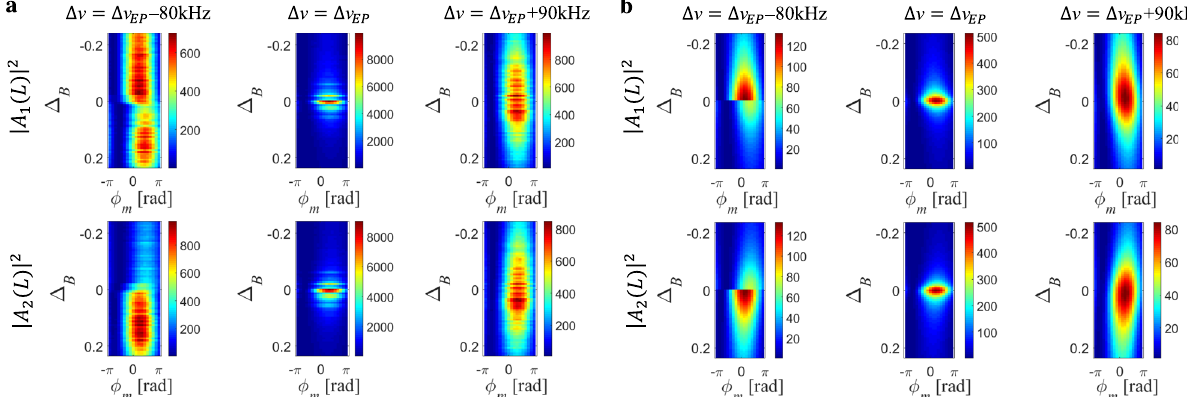
Fig. 5 Enhanced response to small-scale variations from the BFS in eigenmode projections around the EP. a Measured and b calculated squared moduli Þ . The top of the output probe wave projections as a function of the relative phase φ between the input tones and Δ B , in the eigenmode basis of H ð Δ ν ; Δ B m (bottom) row presents projection on the fi rst (second) eigenmode. The frequency detuning between the two probe tones Δ v was fi xed above the EP (right, anti-PT-symmetric regime), at the EP (centre), or below the EP (left, broken-symmetry regime). The two output projections exhibit signi fi cant narrowing when the system approaches the EP from the anti-PT-symmetric regime. Past the EP, asymmetry appears between the two output projections with respect to Δ B , with discontinuity at the BFS corresponding to a branch-cut in the Riemann